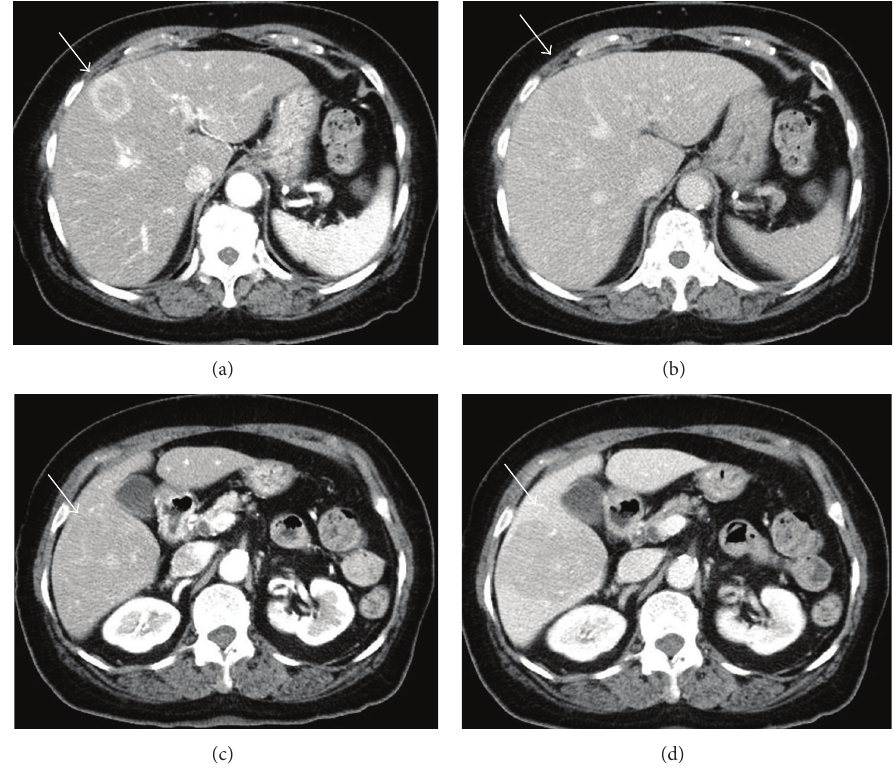
Figure 2: Contrast-enhanced abdominal computed tomography. A 30 × 30 mm mass with an enhanced margin was revealed at segment 8 in the arterial phase (a). The contrast agents were washed out in the venous phase (b). A 63 × 52 mm mass with a density lower than that of liver parenchyma was revealed at segment 8 in the portal phase (c). On the basis of these findings, either a liver abscess or hepatocellular carcinoma was